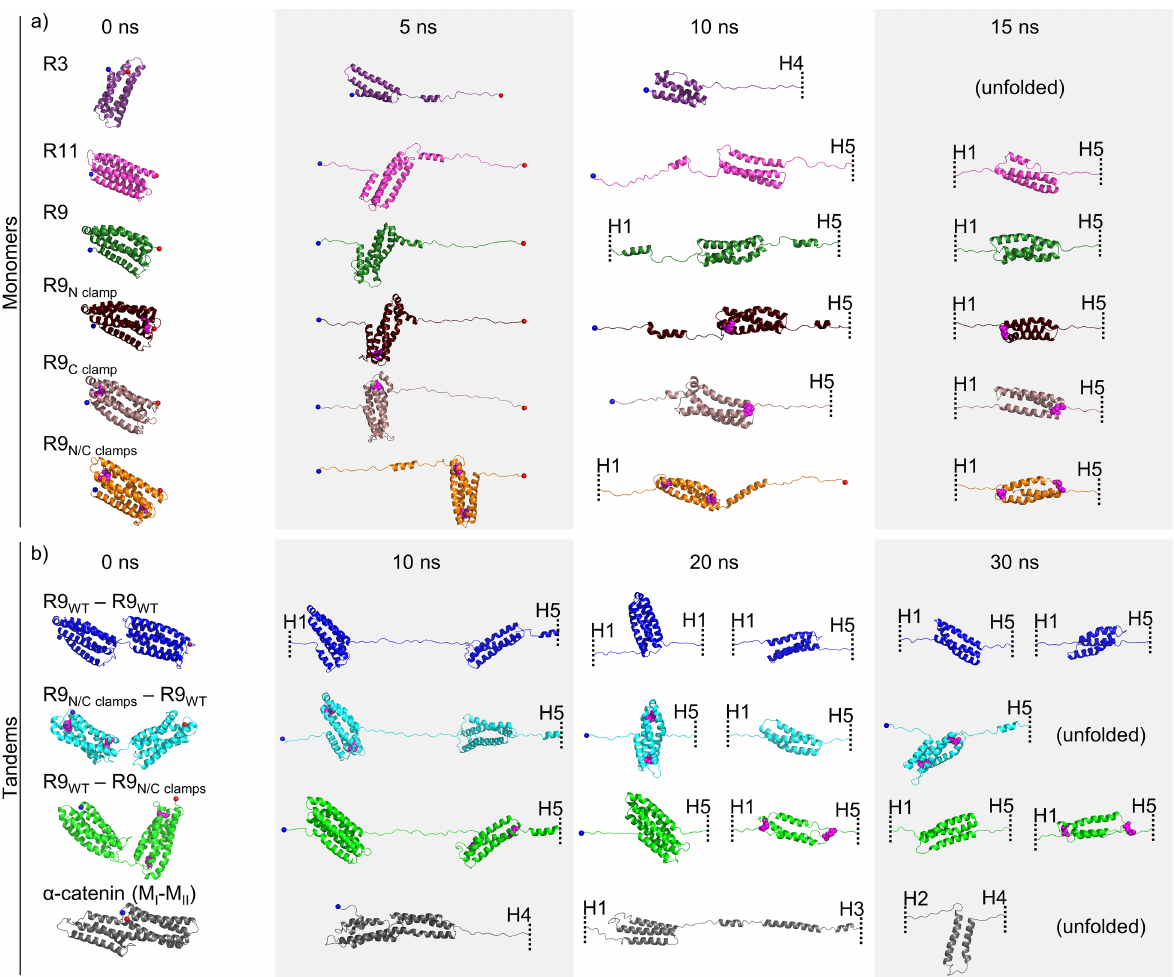
Fig 3. Representative structure snapshots from SMD. Talin rod domain bundles and α -catenin (M I -M II ) in constant velocity SMD simulations. Structures were taken (a) at 0, 5, 10 and 15 ns for monomers, and (b) at 0, 10, 20 and 30 ns for tandem constructs. Cysteine residues forming the disulphide clamps shown as magenta spheres. Unfolded structures are cut away and presented by dashed line with a helix identifier.